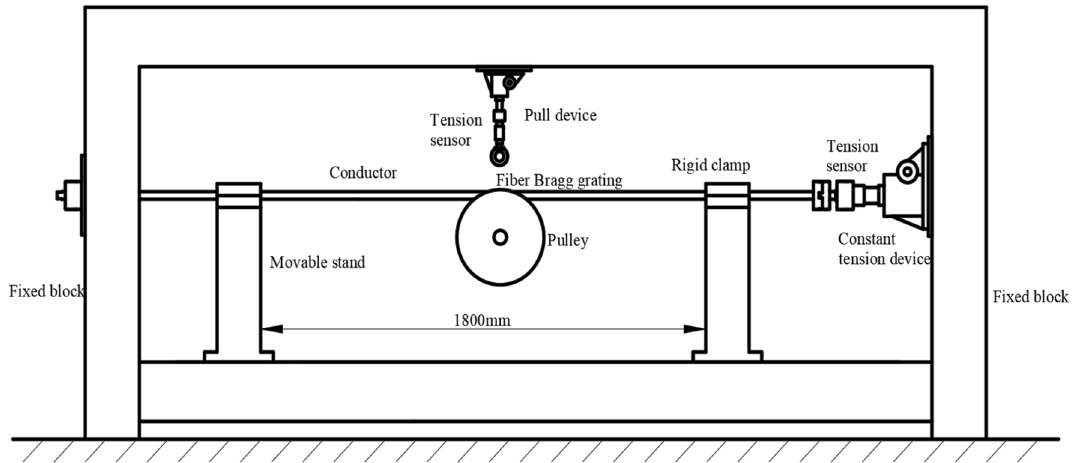
Figure 14. Diagram of mechanical test